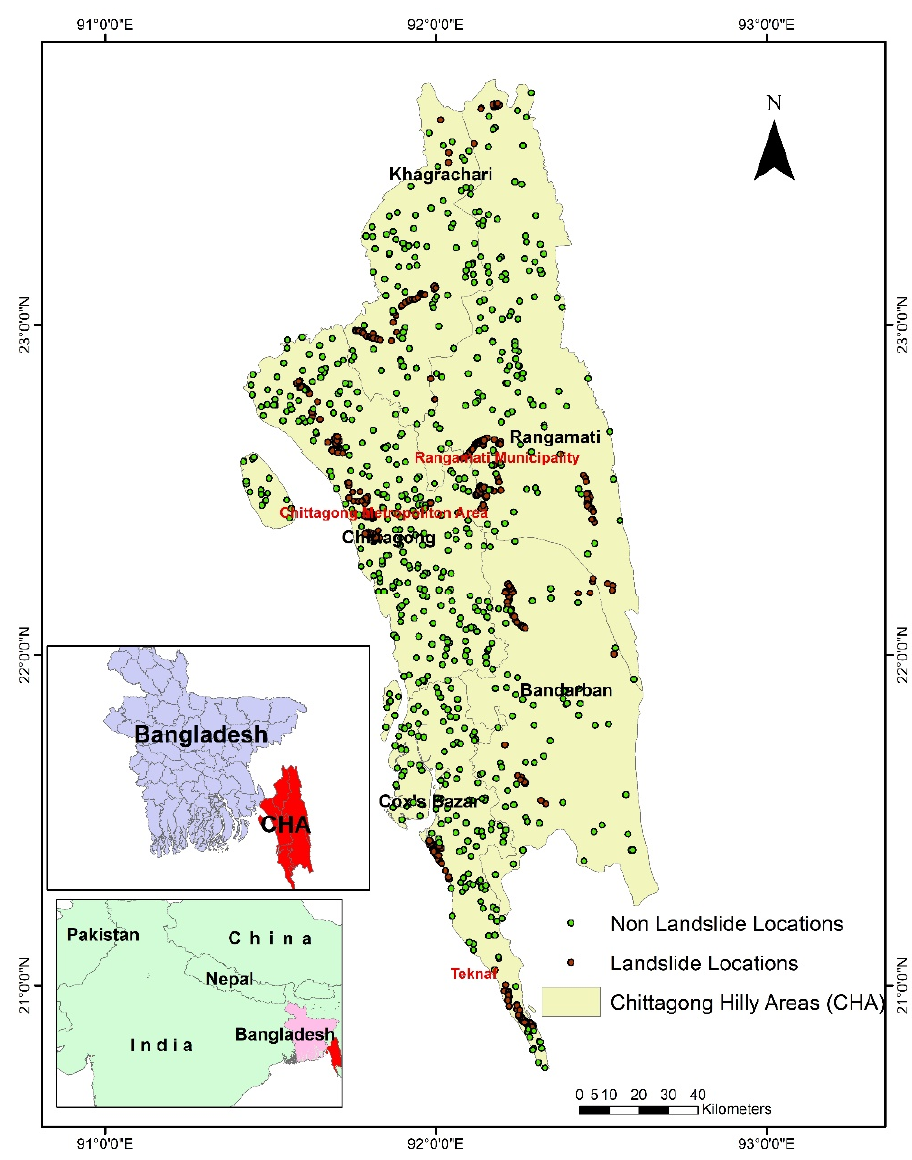
Figure 1. Location of the study area (CHA) and the landslide and non-landslide locations.